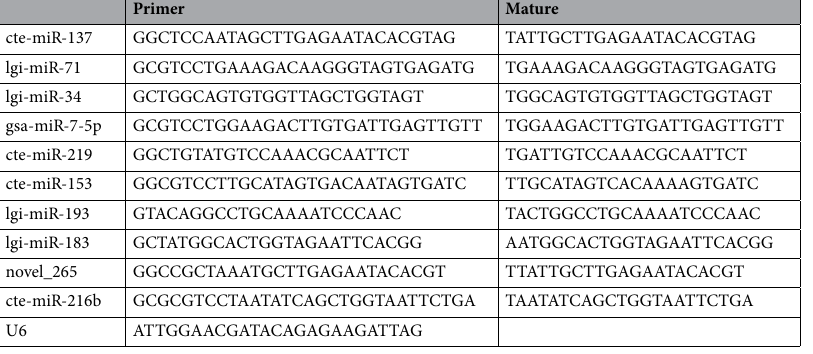
Table 1. Primers used in stem-loop